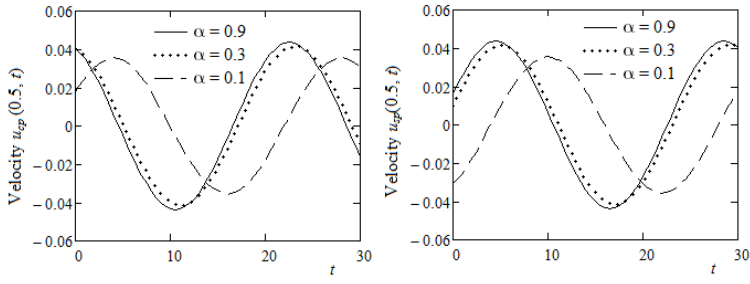
Figure 4. Time variations of the mid plane velocities u cp ( 0.5, t ) and u sp ( 0.5, t ) for Re = 100,We = 1, ω = π /12 and decreasing values of α